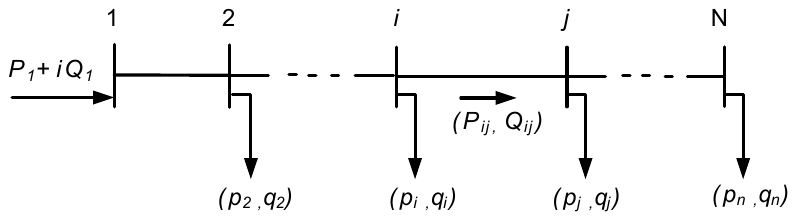
Figure 3. Schematic diagram of single branch radial distribution system with N nodes.